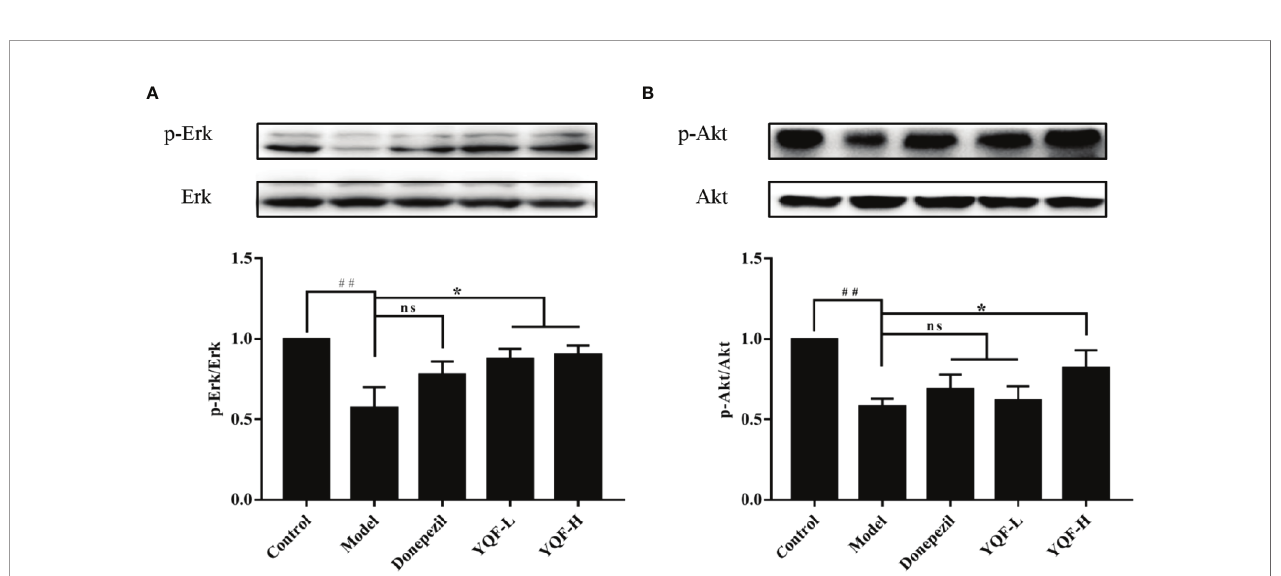
FIGURE 8 | Effect of YQF extract on phosphorylation of Erk and Akt in hippocampus. (A) YQF extract increased Erk phosphorylation. (B) YQF extract increased Akt phosphorylation. The data are expressed as mean ± SEM, n = 4. ## p < 0.01, compared with control group; * p < 0.05, compared with Model group. ns: no signi fi cant